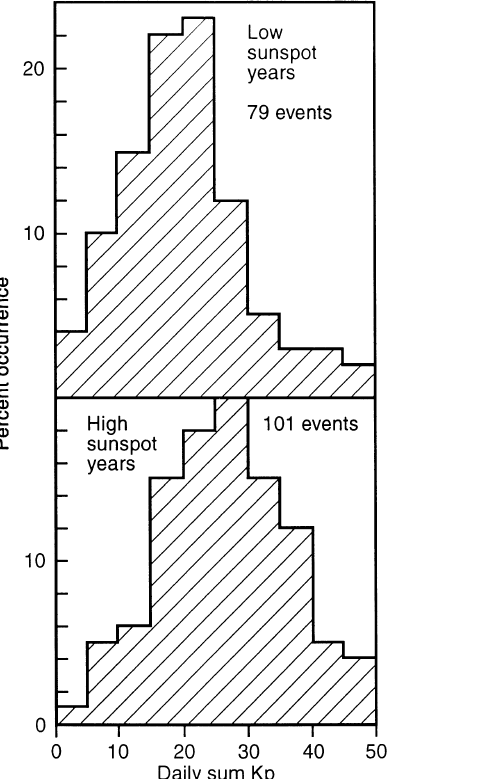
Fig. 3. Distribution of daily sum Kp index (cid:133) (cid:82) kp (cid:134) on days of No - E s - q event during midday hours for low and high sunspot years